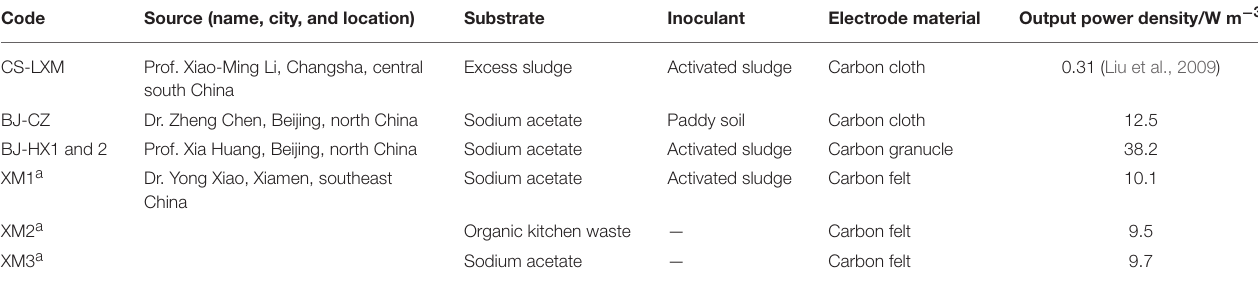
TABLE 1 | Characteristics of the anodic electrochemically active biofilm samples.